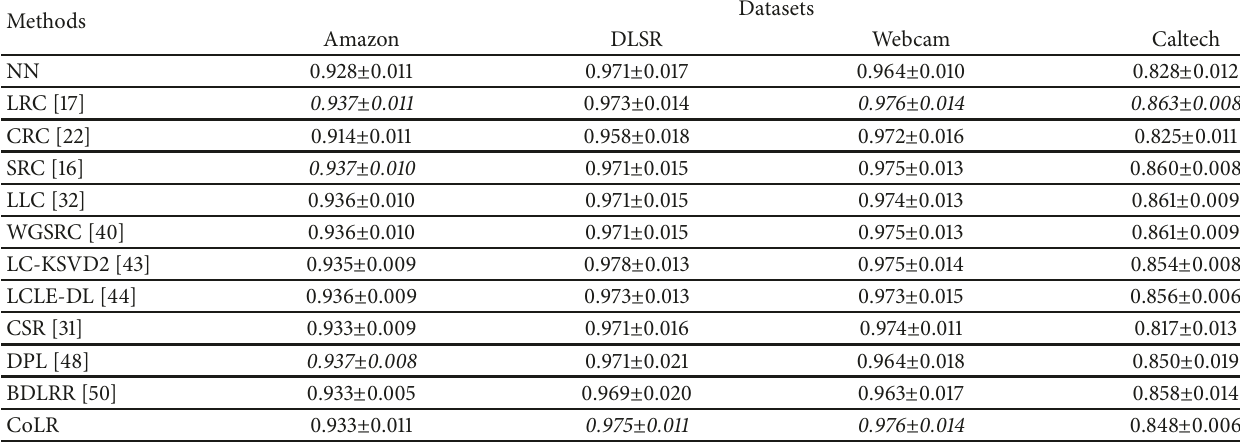
Table 11: Recognition rates of each method on 4DA datasets using 𝑓 7 CNN-layer